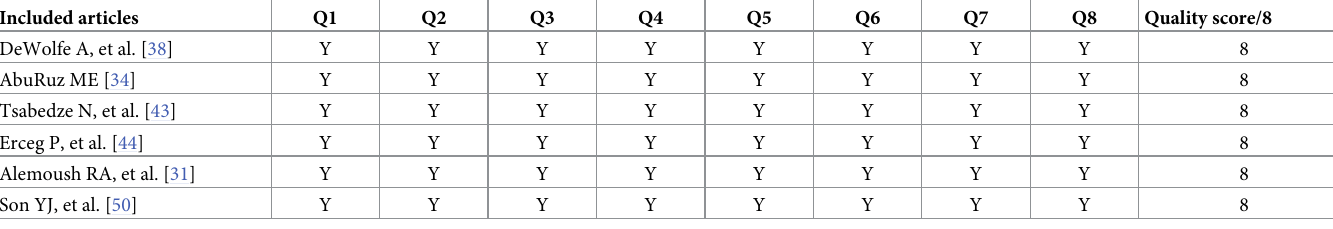
Table 5. Methodological quality of included studies for association of depression and